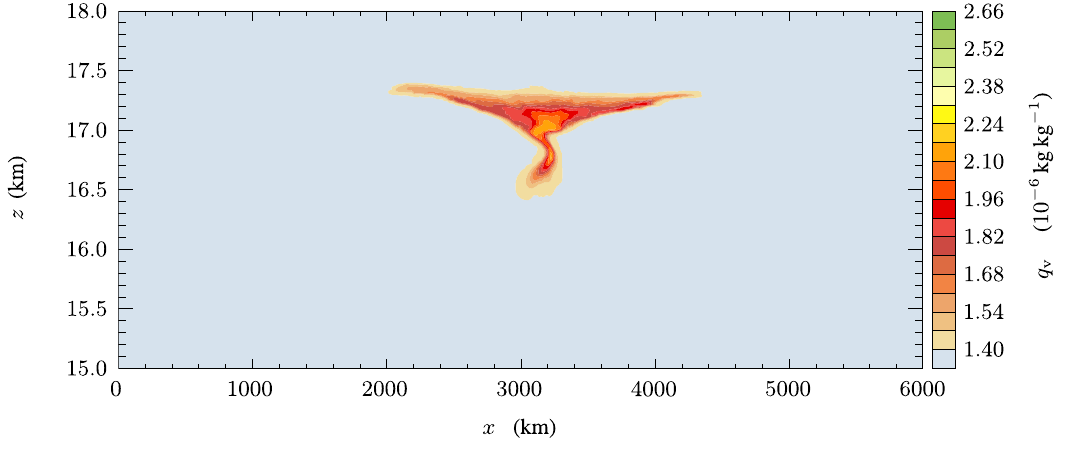
Fig. 10. Water vapor mixing ratio at the end ( t = 12d) of the